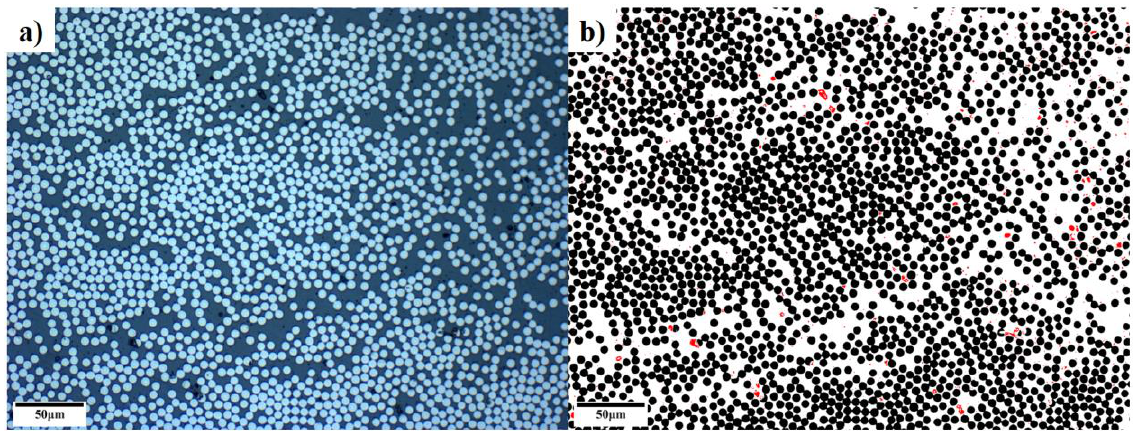
Figure 4. ( a ) Optical microscopy of the UD-CFRP sample cross-section for 59.8% FVF. ( b ) Resin (white), fibres (black), and voids (red) identified by ImageJ software filters.